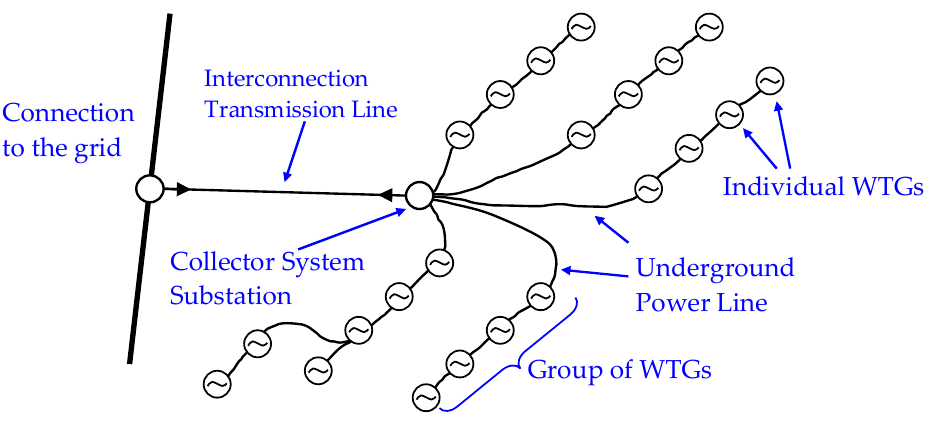
Figure 1. Wind power plant topology.